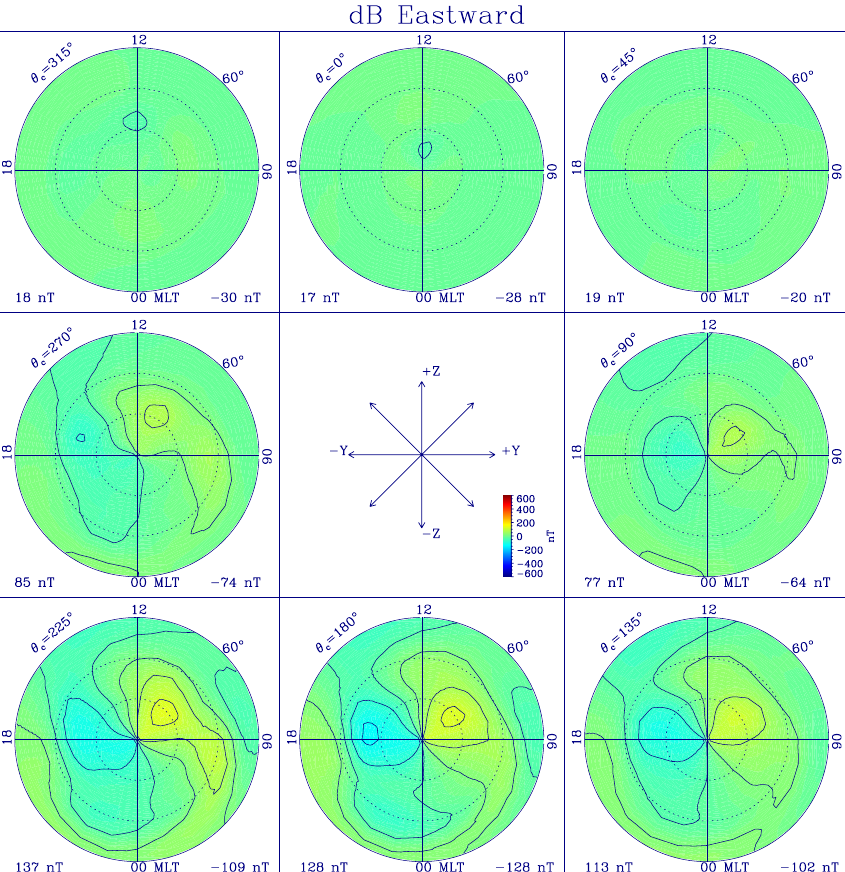
Fig. 4. Evolution of eastward component of the geomagnetic perturbations as the IMF clock angle rotates in the same format as Fig. 3. Eastward is specified as